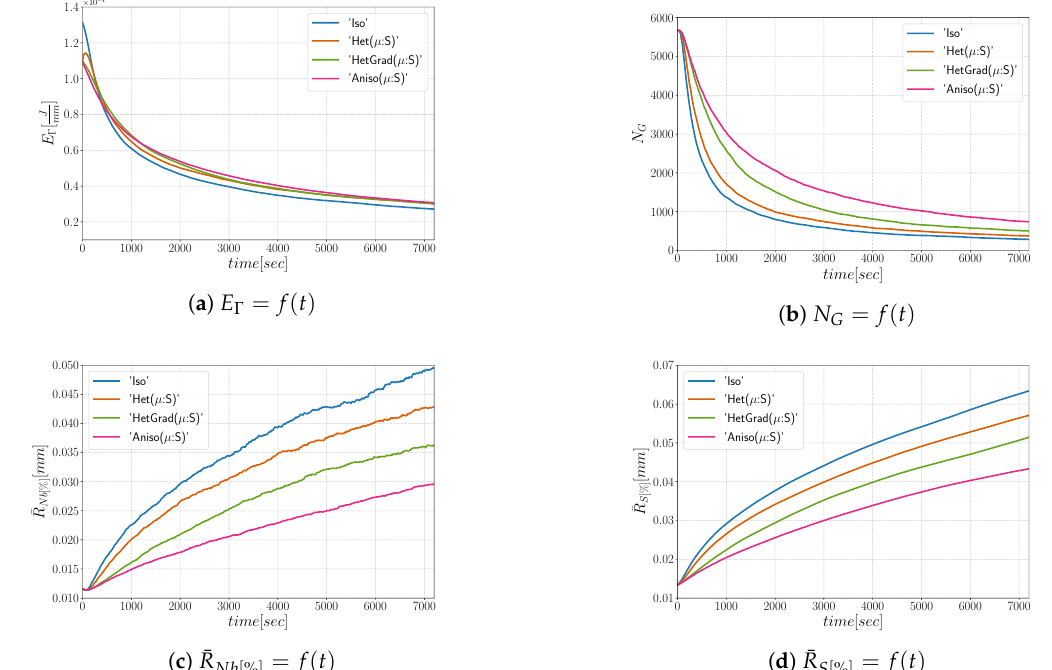
Figure A12. Time evolution for the different formulations: ( a ) the total GB energy, ( b ) the number of grains, ( c ) the mean radius weighted by number, and ( d ) the mean radius weighted by surface.